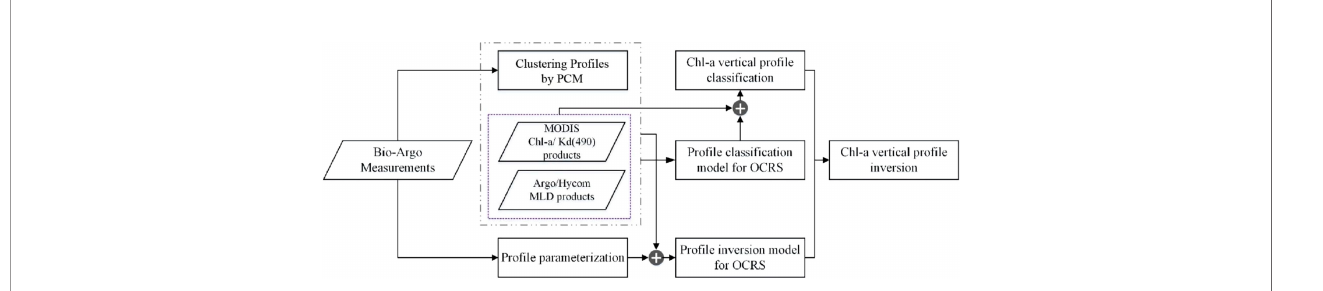
FIGURE 2 | Flowchart of the proposed method for reconstructing Chl-a vertical pro fi les in the Mediterranean